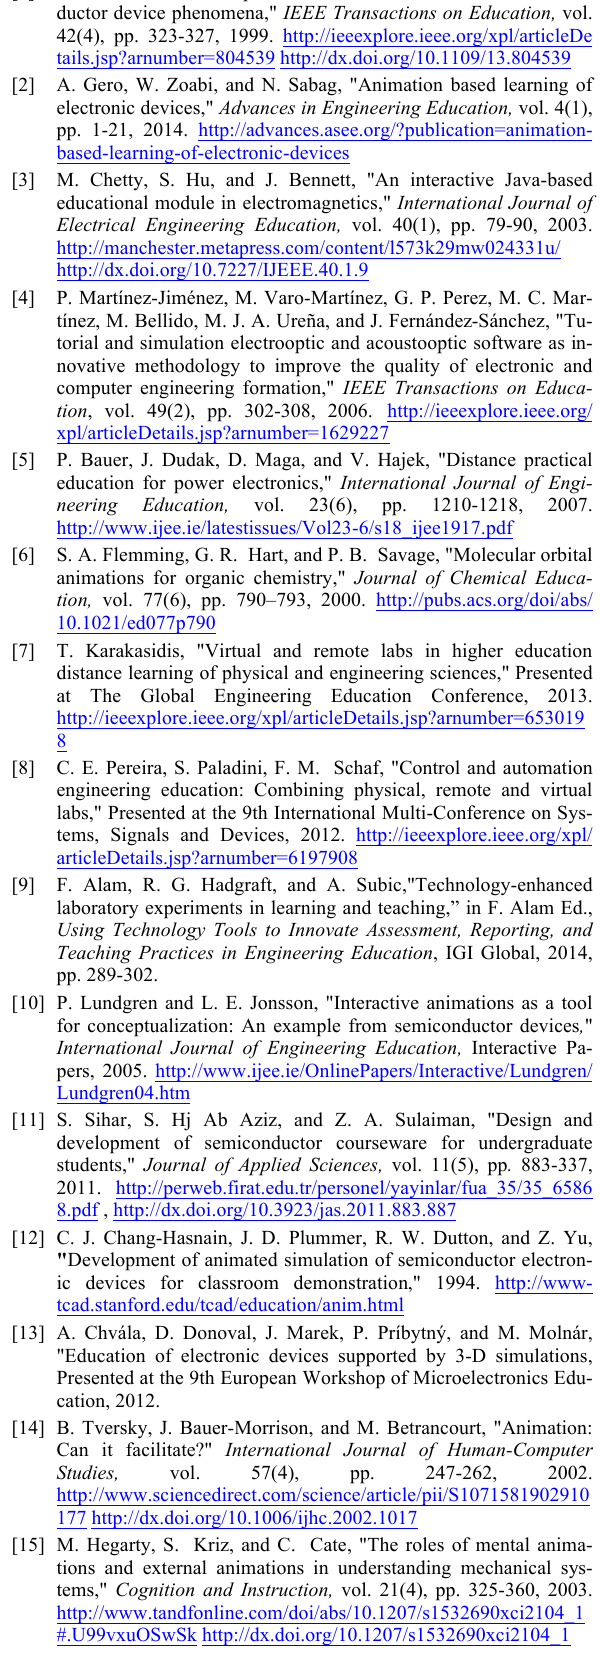
Figure 2. Sample question (Test 1)